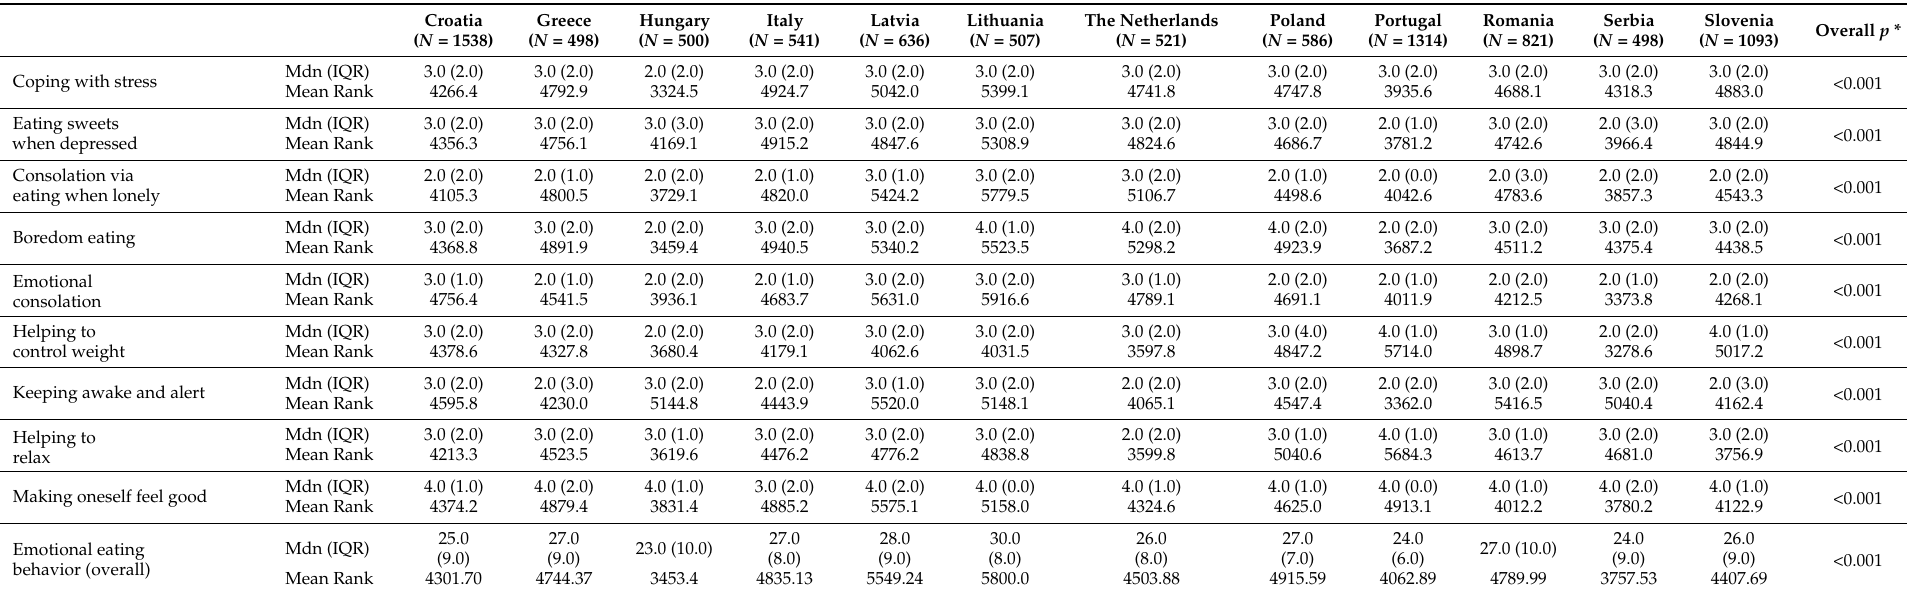
Table 2. The difference in emotional conditions of food consumption of the study population ( N =